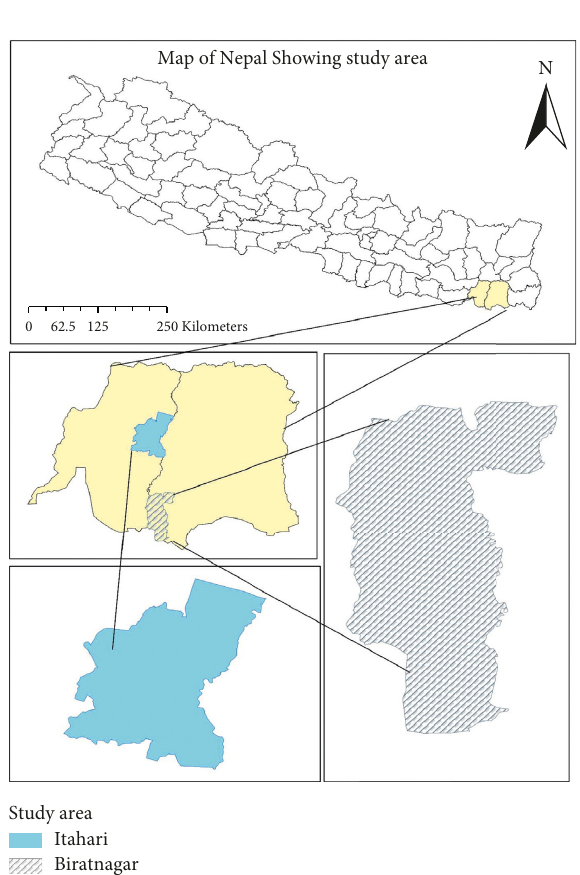
Figure 1: Map of Nepal showing study area (ArcGIS